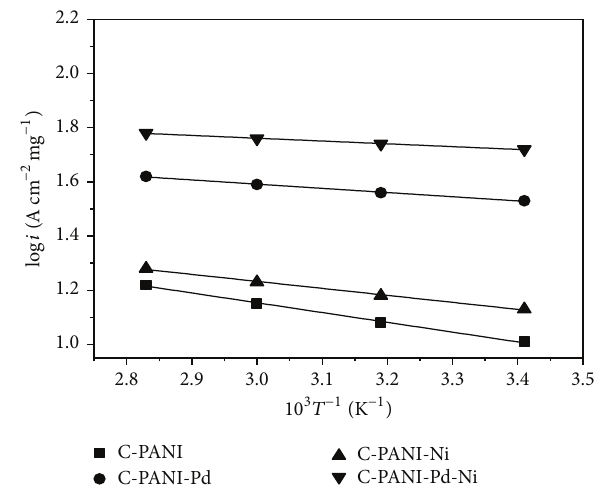
Figure 6: Arrhenius plots for methanol oxidation on different electrodes in 0.5 M H 2 SO 4 solution containing 1.0M methanol at 0.2 V.